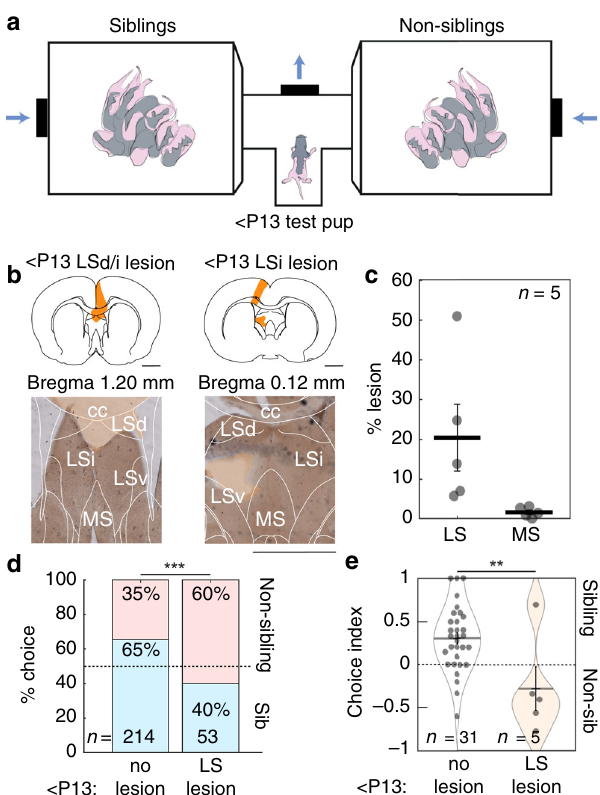
Fig. 2 Sibling preference in young pups is disrupted by lesion of the lateral septum. a Apparatus for sibling-preference testing. Test pup was placed in the T-tube with two opposing chambers containing sibling and non- sibling rats. Air was blown toward the center of the T-choice tube. b Examples of two sections from two pups with lateral septal lesions. Left, lesion of dorsal and intermediate lateral septum (LSd/i) with overlying cortex. Right, lesion of intermediate lateral septum (LSi) and cortex (lesion area in orange). Scale bar applies to left and right micrographs. c Sections (100 µ m thickness) of the fi ve lesioned brains were analyzed for lesion extent. Average percent lesion of septum was estimated (LS: 20.45±8.36%; MS: 1.53±0.56%). Data represent the mean ±s.e.m. d Sibling preference in intact animals and with lateral septum lesion. Bars represent proportions of categorical choices pooled across animals (<P13 No lesion (as in Fig. 1d): 140 sibling choices, 74 non-sibling choices; <P13 lateral septum lesion: 21 sibling choices, 32 non-sibling choices; p = 8.9e − 4, Fisher ’ s exact test). e Sibling choice behavior by animal, non-lesioned data as in Fig. 1e (<P13 No lesion vs. LS lesion: p = 0.005, t -test). Data represent the mean ±s.e.m. All tests are two-tailed. For detailed statistical information, see Supplementary Table 1. LSd dorsal lateral septum, LSi intermediate lateral septum, LSv ventral lateral septum, cc corpus callosum, MS medial septum. Scale bars: 2mm. ** p < 0.01, *** p <